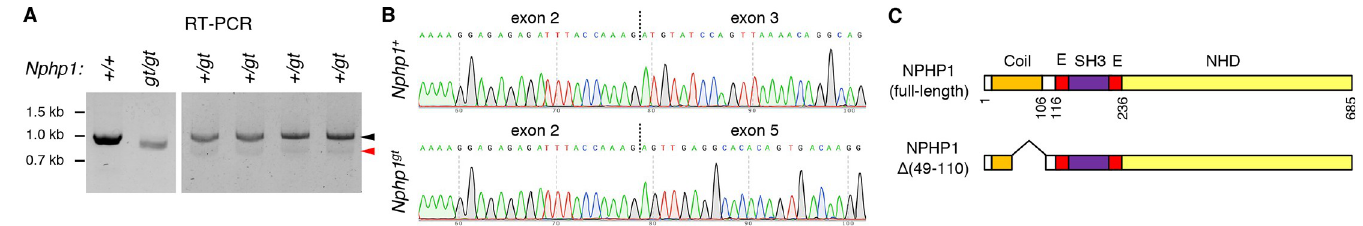
Fig 4. A small quantity of functional mRNA is produced from the Nphp1 gt allele via nonsense-associated altered splicing. (A) Nphp1 RT-PCR data from Nphp1 +/+ , Nphp1 gt/gt , and Nphp1 +/gt retinas. Black and red arrowheads indicate PCR products from the wild-type and the Nphp1 gt allele, respectively. Each animal’s Nphp1 genotype is shown at the top. Locations of DNA size markers are shown on the left. (B) Chromatogram of RT-PCR product sequencing reactions around exon-exon junctions. Vertical dotted lines indicate exon-exon junctions. (C) Schematic representation of NPHP1 protein products encoded by wild-type and Nphp1 gt alleles. Major structural domains are depicted (Coil: coiled-coil domain; E: Glu-rich domain; SH3: SH3 domain; NHD: nephrocystin homology domain). Amino acid positions are shown below full-length NPHP1 and based on the translated amino acid sequence of BC118953.